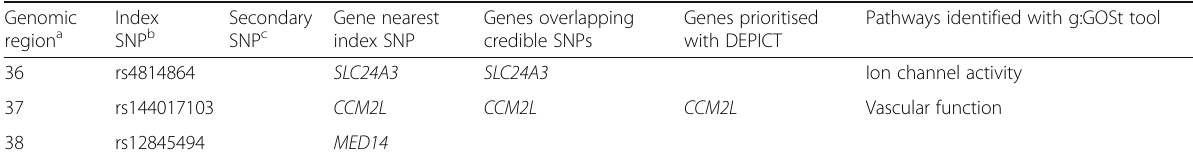
Table 1 Migraine-associated single nucleotide polymorphisms and the molecular pathways they are linked to (Continued) Genomic region